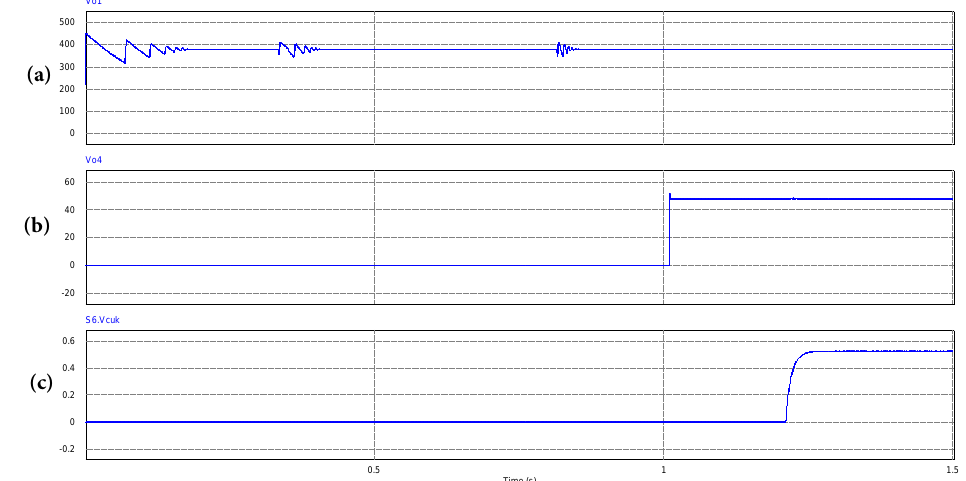
Figure 30. Fourth set of simulation results, ( a ) primary DC bus, ( b ) 1.2 kW converter output voltage and ( c ) Cuk driver reference signal. Waveforms are: in Figure 30a, primary bus voltage as time reference; 400 W voltage output converter, Figure 30b, finally, Cuk convertert voltage output to supply one of the six luminaries on the set, see Figure 30c. The same longest trajectory is reviewed again, but luminaries connection appear in Figure